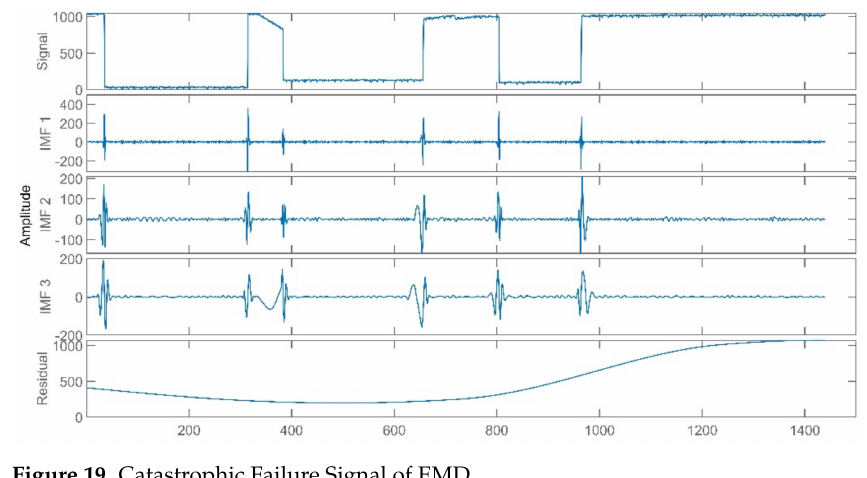
Figure 19. Catastrophic Failure Signal of EMD.